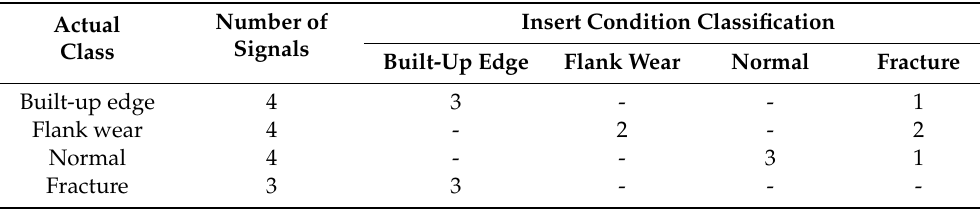
Table 9. Insert condition classification results. (cutting speed 323 m / min, depth of cut 2.3 mm, cutting feed 0.14 mm /